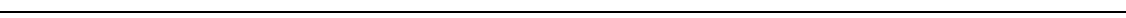
Fig. 7 Role of LKB1/AMPK tumor suppressor axis on DVL ’ s function on YAP. a The MCF-10A cells expressing tetracycline-inducible shRNA against DVL3 were cultured under sparse culture condition and treated with 2-deoxyglucose (2DG, 3 mM) and metformin (Met, 5 mM) for 16 h period in absence ( − ) or presence ( + ) of doxycycline (Dox). Endogenous YAP localization was determined by confocal microscopy. Inset, DAPI nuclear stain; Scale bar, 10 μ m. b The wt and DVL-TKO 293 T-REx cells were treated with 2DG and Met, and nuclear YAP abundance was then determined by immunoblot analysis (left panels) and confocal microscopy (right panels). Inset, DAPI nuclear stain; Scale bar, 5 μ m. c Kinase-dead GFP-fused AMPK or fl ag-tagged LKB1 mutant was co-transfected with control ( − ) or HA-tagged DVL3 ( + ) in 293 cells. Whole-cell lysates (WCL) were immunoblotted with indicated antibodies, and nuclear fractions were used for nuclear YAP abundance (left panels). The TEAD (right upper) or TCF/LEF (right lower) reporter was co-transfected with DVL in empty vector transfected cell (vector) or kinase-dead AMPK (AMPK-KD) or LKB mutant (LKB-KD), and the relative fold repression of reporter activity was measured from triplicate experiments (mean ± SD). d The wt and AMPK α 1/ α 2 double-knockout (DKO) MEFs were stably transfected with inducible DVL3 and nuclear YAP abundance was examined by immunoblot analysis (left panels) and immuno fl uorescence (right panels) in the absence ( − ) or presence ( + ) of doxycycline for a 48 h period. Upper inset, DAPI nuclear stain; Lower inset, HA (DVL3); Scale bar, 5 μ m. e The A549 cells were stably transfected with inducible DVL3, and nuclear YAP abundance and DVL3 localization under sparse or con fl uent culture condition were examined by immunoblot analysis (left panels) and immuno fl uorescence (right panels) in presence of doxycycline. Inset, DAPI nuclear stain; Scale bar, 5 μ m. f The 293 cells (1 × 10 6 ) were transiently transfected with YAP and DVL3 in combination with vector control or LKB-KD mutant, and the cells were inoculated into the fl ank of athymic nude mice ( n = 10). The empty vector or LKB-KD transfected cells served as control. Tumor volume was measured 5 weeks